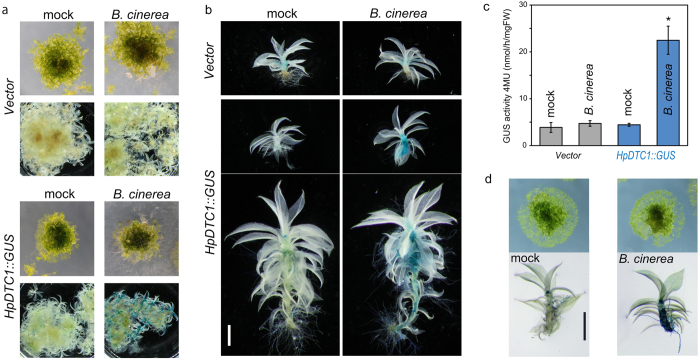
The HpDTC1 promoter is induced by Botrytis cinerea infection in the moss Physcomitrella patens.(a,b) The pathogenic fungus, B. cinerea, was inoculated onto colonies of HpDTC1::GUS and vector control lines and then the culture plate was incubated for 4 days at 24 °C. The HpDTC1::GUS plants were histochemically stained. Scale bars: 1 mm. (c) The quantitative data for HpDTC1::GUS reporter induction by B. cinerea infection after 4 days incubation. The GUS activity was fluorometrically determined. Data are presented as mean ± standard deviation of biological replicates. (n = 5–8, *p < 0.01.). (d) Application of sterilized mycelia of B. cinerea induced HpDTC1::GUS reporter expression. The mycelia were placed on a HpDTC1::GUS colony and then incubated for 4 days at 24 °C.